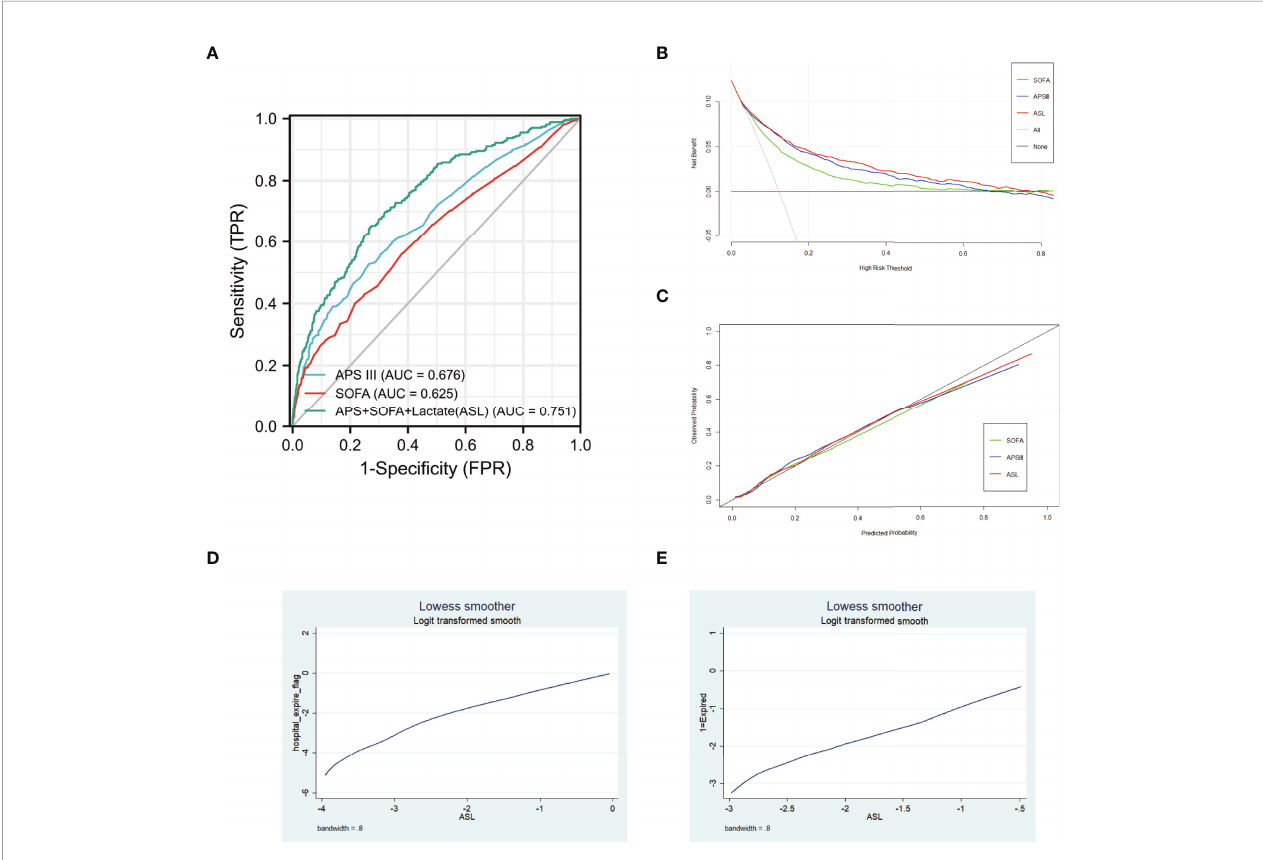
FIGURE 8 | (A) Receiver operating characteristic (ROC) curves of three different indicators in eICU cohort. (B) DCA curves of three different indicators in eICU cohort. (C) Calibration curves of three different indicators in eICU cohort. (D) Association between ASL and hospital mortality in MIMIC-IV cohort using Lowess. (E) Association between ASL and hospital mortality in eICU cohort using